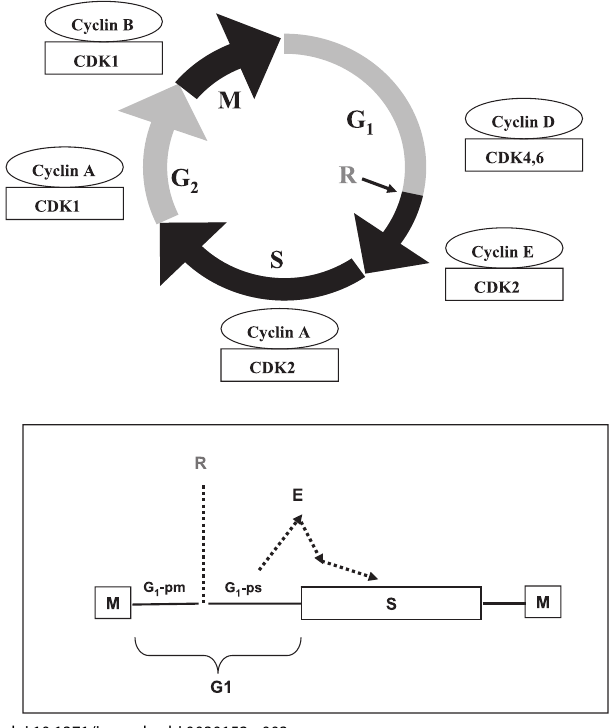
Figure 3. The Mammalian Cell Cycle Showing the G1, S, G2, and M Phases along with the Predominant Cyclin–CDK Activities Associated with Each Phase (Top Panel) The lower panel shows the position of the R point (R) which subdivides the G1 phase into G1-pm (post-mitosis) and G1-ps (pre-S-phase). Quiescent or non-dividing cells have to be exposed to continuous growth-factor stimulation up until the R point in order to commit to entry into S-phase. After R and a finite induction period, cyclin E/CDK2 activity increases (shown by the dashed curve labelled E) as reported by Ekholm et al. [6].